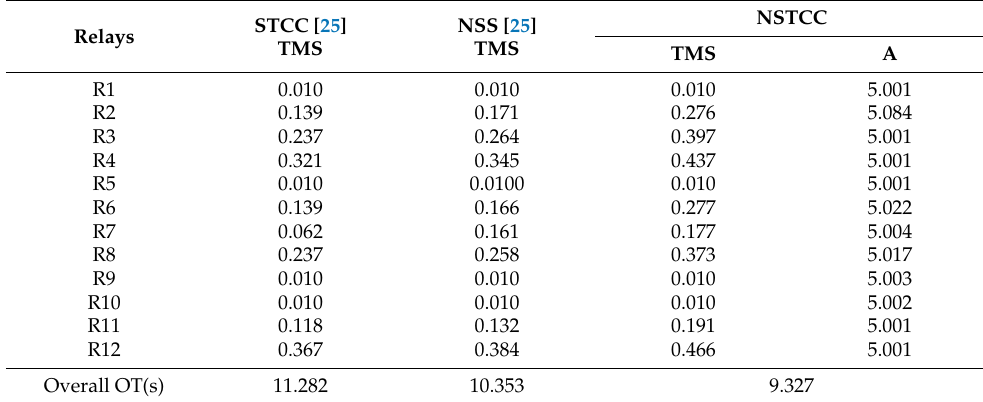
Table 4. The Overall OT for STCC, NSS, and NSTCC Curves in IEEE 9-Bus (DGs- Mode 2). Relays